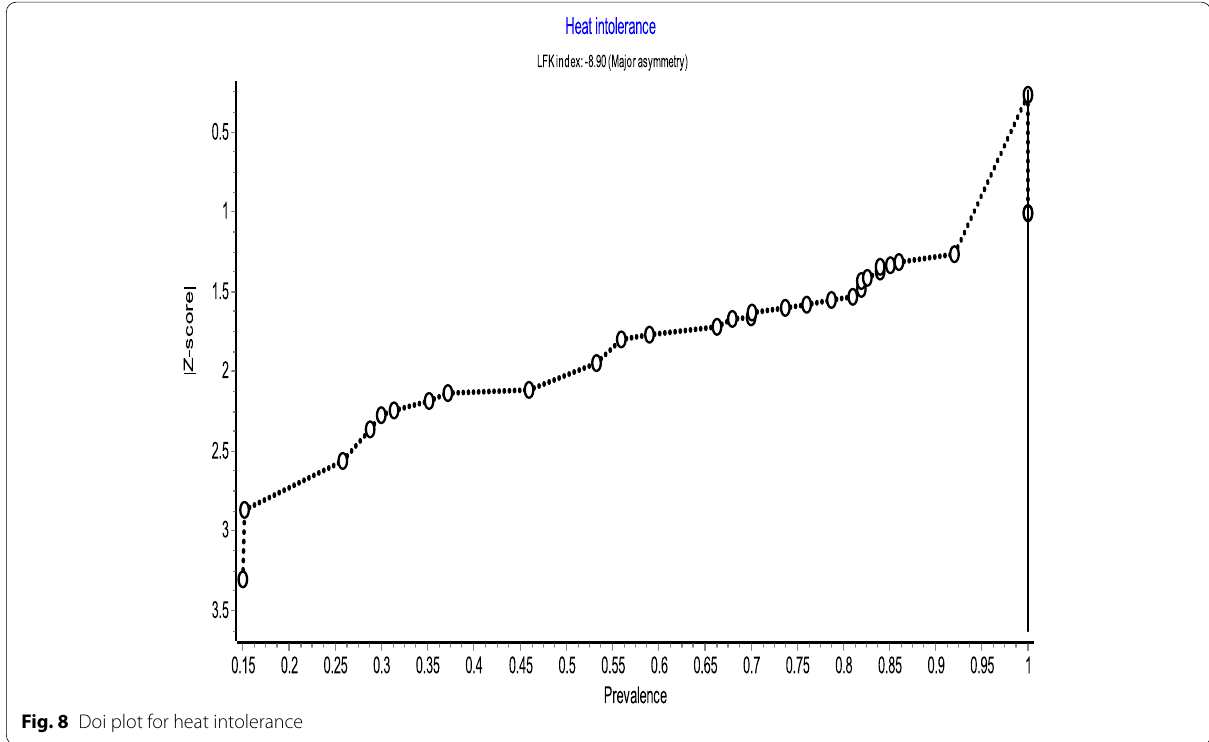
Fig. 8 Doi plot for heat intolerance